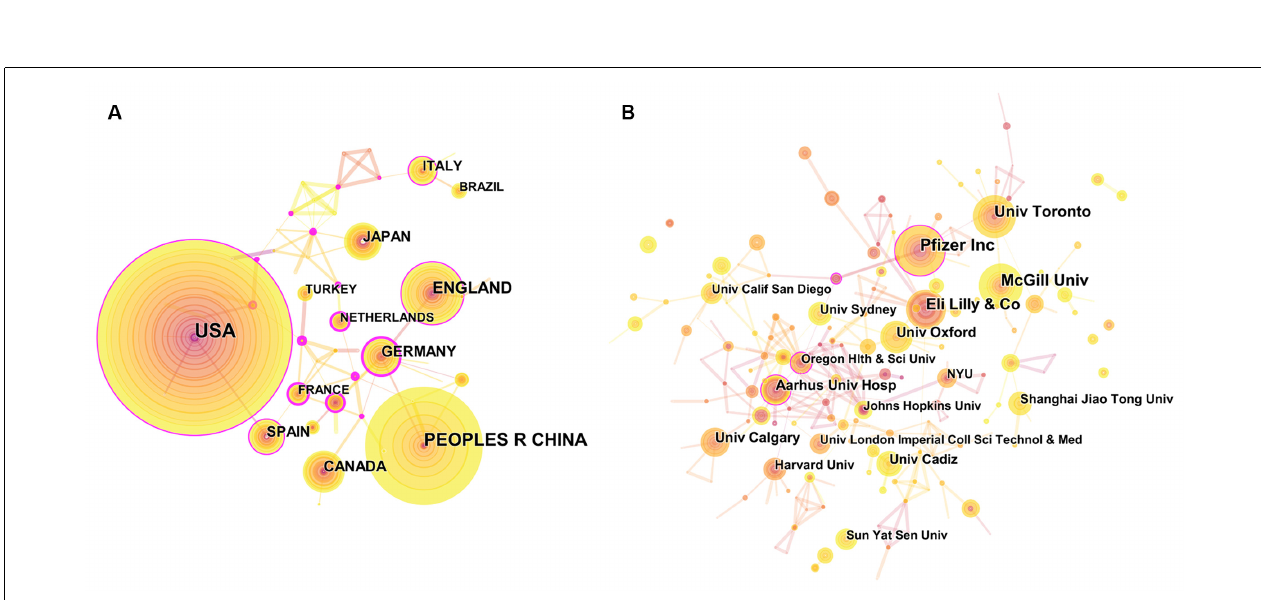
FIGURE 6 | The analysis of countries/regions and institutions. (A) Network map of countries/regions engaged in NP associated with anxiety or depression research. (B) Network map of institutions engaged in NP associated with anxiety or depression